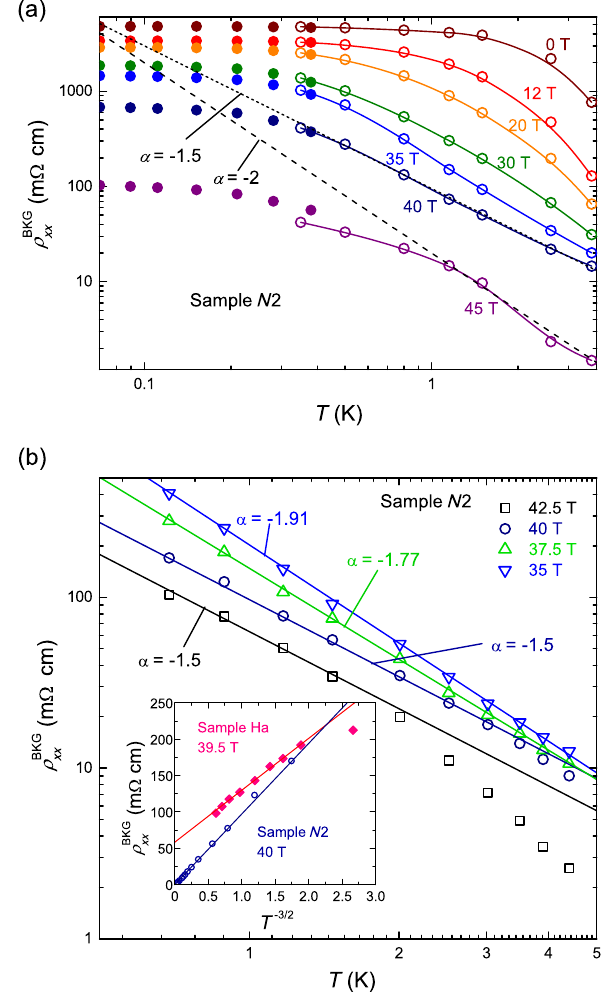
FIG. 6. (a) The nonoscillatory background resistivity ρ BKG of xx YbB 12 sample N 2 as a function of the temperature at several magnetic fields from 0 to 45 T, plotted on a log-log scale. Open and solid symbols are data taken in the 3 He cryostat at magnetic field tilt angle θ ¼ 7 . 4 ° and in the dilution refrigerator at θ ¼ 8 . 5 ° in the 45-T hybrid magnet [35]. Solid lines are guides to the eye. ∝ T α with α ¼ − 2 and Dashed and dotted lines denote ρ xx α ¼ − 1 . 5 , respectively. (b) ρ BKG T Þ of sample N 2 at μ 0 H ¼ xx ð 35 T (down triangles), 37.5 T (up triangles), 40 T (circles), and 42.5 T (squares) measured in a pulsed magnet with H applied along [001]. Solid lines indicate the power-law T dependence ρ BKG T Þ ¼ A ð H Þ T α . (Inset) ρ BKG plotted against T − 3 = 2 xx ð xx